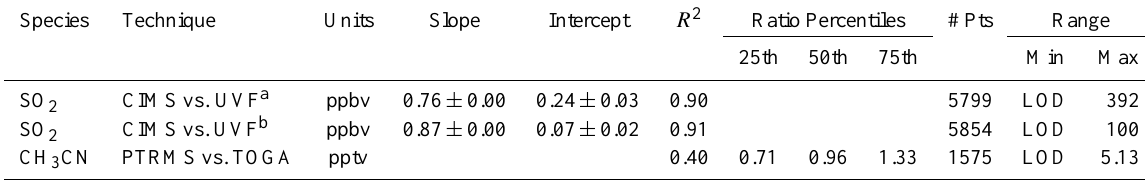
Table 5a. C-130 intra-platform comparison. Gas phase tracers. NOTE: Technique is listed as X vs. Y. Species Technique